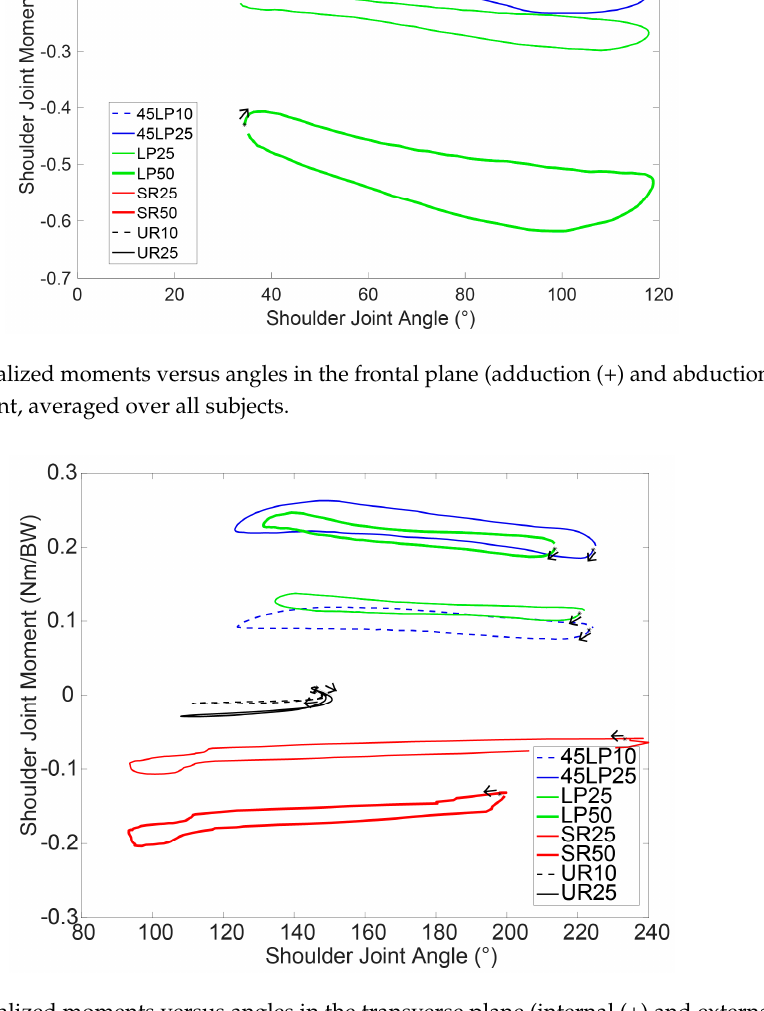
Figure 4. Normalized moments versus angles in the transverse plane (internal (+) and external ( − ) in the shoulder joint, averaged over all subjects.